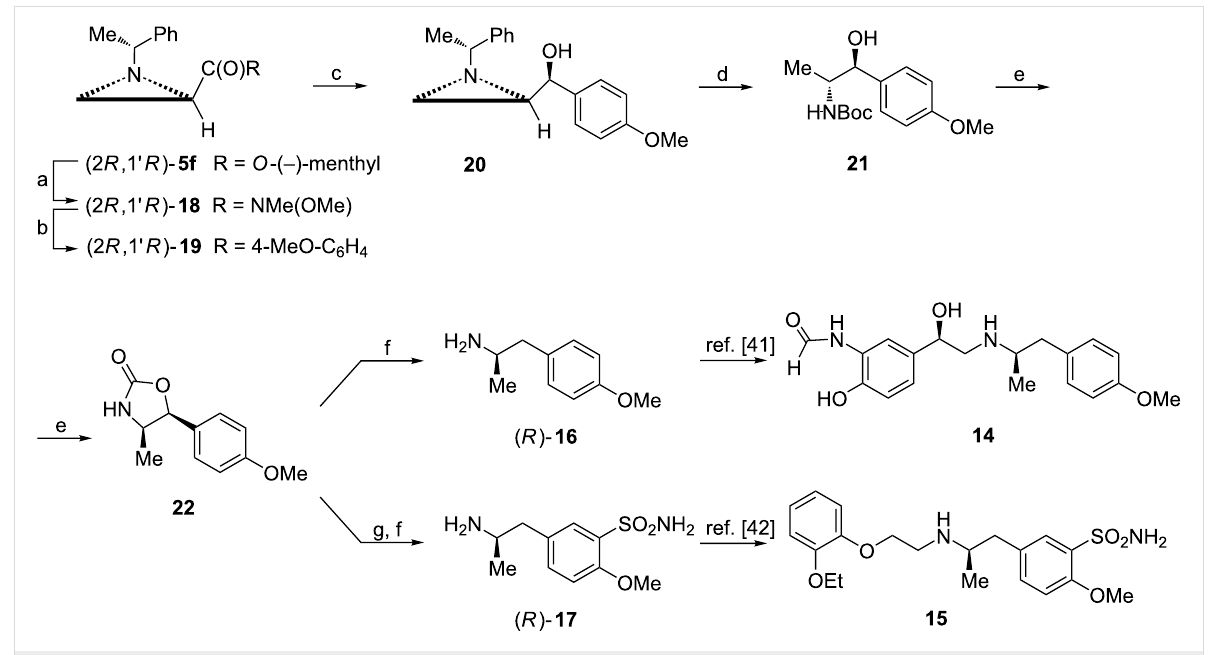
Scheme 5: Synthesis of key intermediates ( R )- 16 and ( R )- 17 for ( R , R )-formoterol ( 14 ) and ( R )-tamsulosin ( 15 ). Reagents and conditions: a) MeONHMe, iPrMgCl, THF, 0 °C, 0.5 h; b) 4-MeOC 6 H 4 MgBr, THF, − 10 °C, 1 h and 0 °C, 0.5 h; c) NaBH 4 , ZnCl 2 , MeOH, − 78 °C, 0.5 h; d) H 2